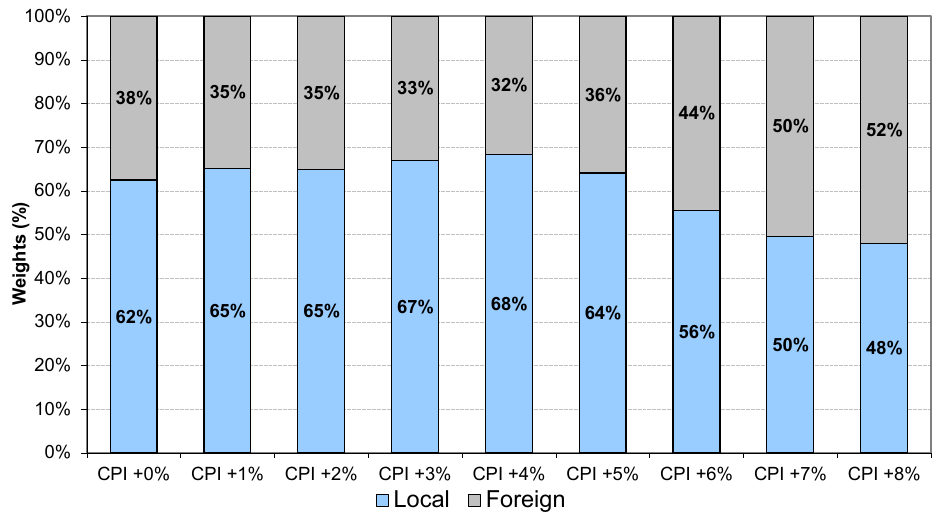
Figure 4 Unconstrained local/foreign allocation weights that had the highest probability of outperforming Inflation + targets over a 3-year investment period (January 1971 to December